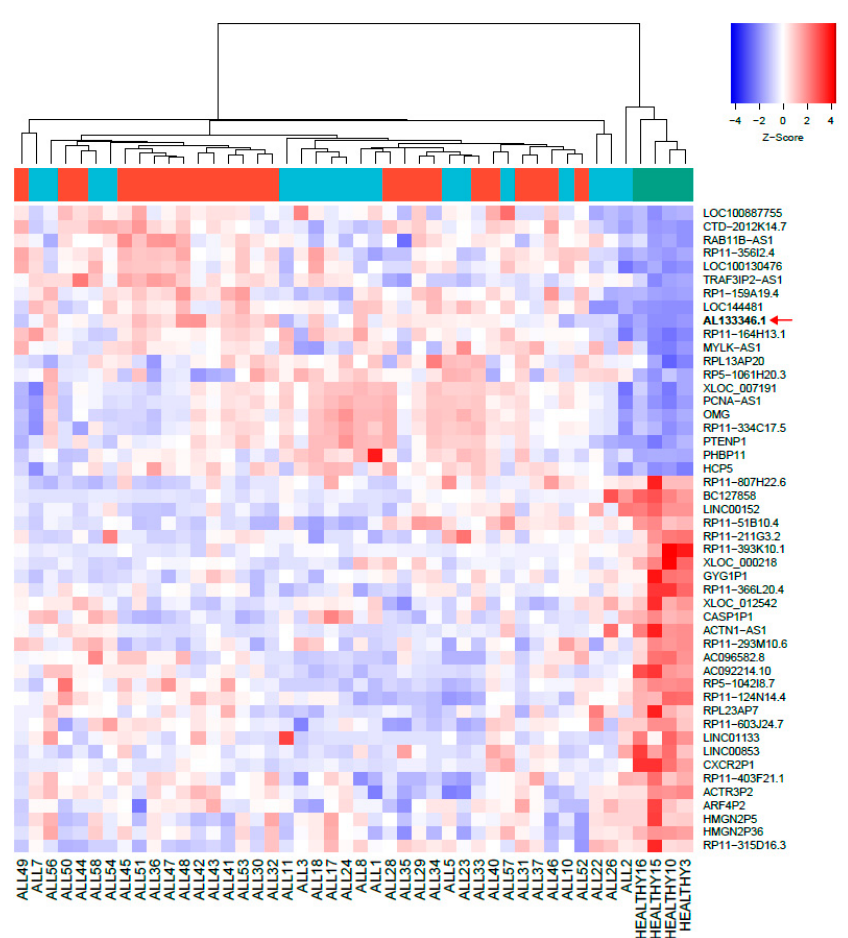
Figure 1. Heatmap of di ff erentially expressed lncRNAs in B-ALL vs. healthy bone marrows. On top of the heatmap, ETV6-RUNX1-negative B-ALL samples are labeled in blue, ETV6-RUNX1-positive B-ALL samples are labeled in red, and healthy bone marrows are labeled in green. Clustering was performed based on the Spearman correlation coefficient.